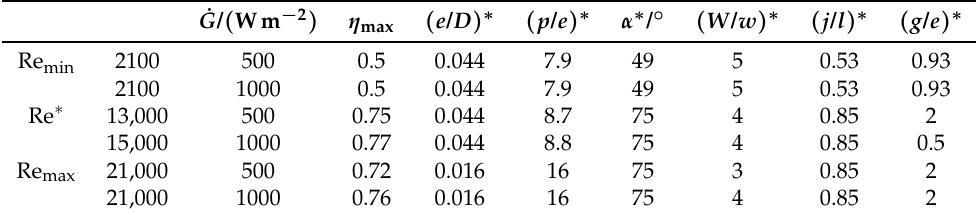
Table 7. Maximum efficiency and optimum roughness parameters according to the model developed by Pandey et al.